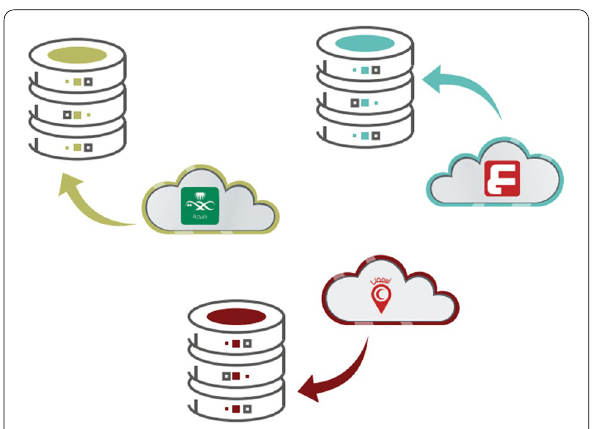
Fig. 1 A Model about separated, non-integration hajj health